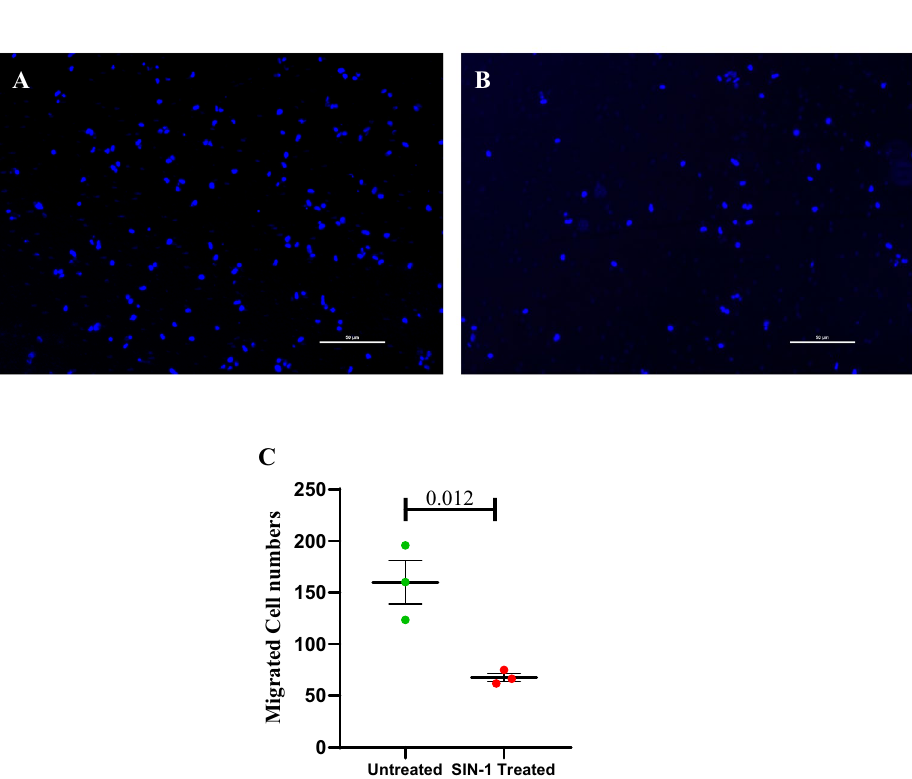
Figure 12. Effect of SIN-1 on ECFC’s migration . (A , B ) represents transwell migrated cells with DAPI nuclear staining; ( A ) Untreated; ( B ) SIN-1 treated. Dot plot ( C ) represents number of migrated cells in lower chamber in untreated and SIN-1 treated groups with individual data points and error bars (n = 3 for each group). Significance was assessed by student ttest and data is represented as mean ± SE. Error bar represent standard error of mean; dots represent average values of the parameter obtained from experimental duplicates p < 0.05 was considered statistically